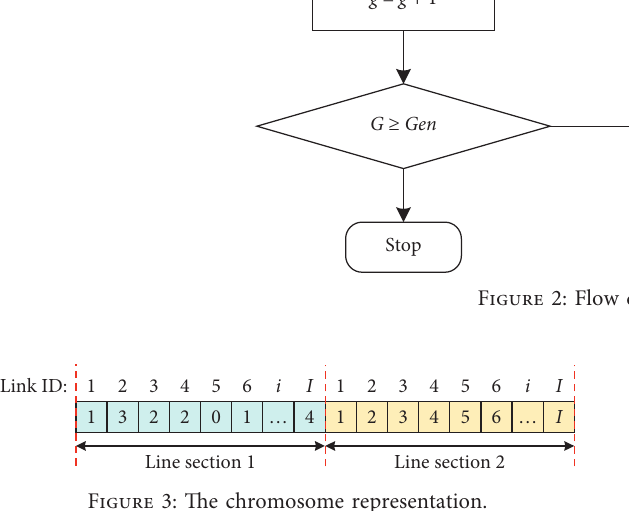
Figure 3: The chromosome